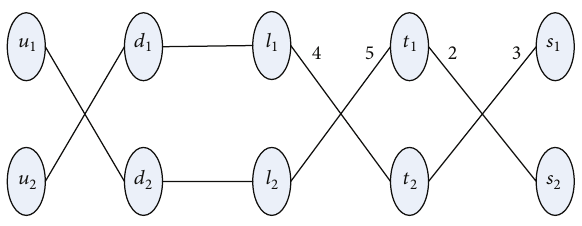
Figure 4: The network model of the tourist behavior